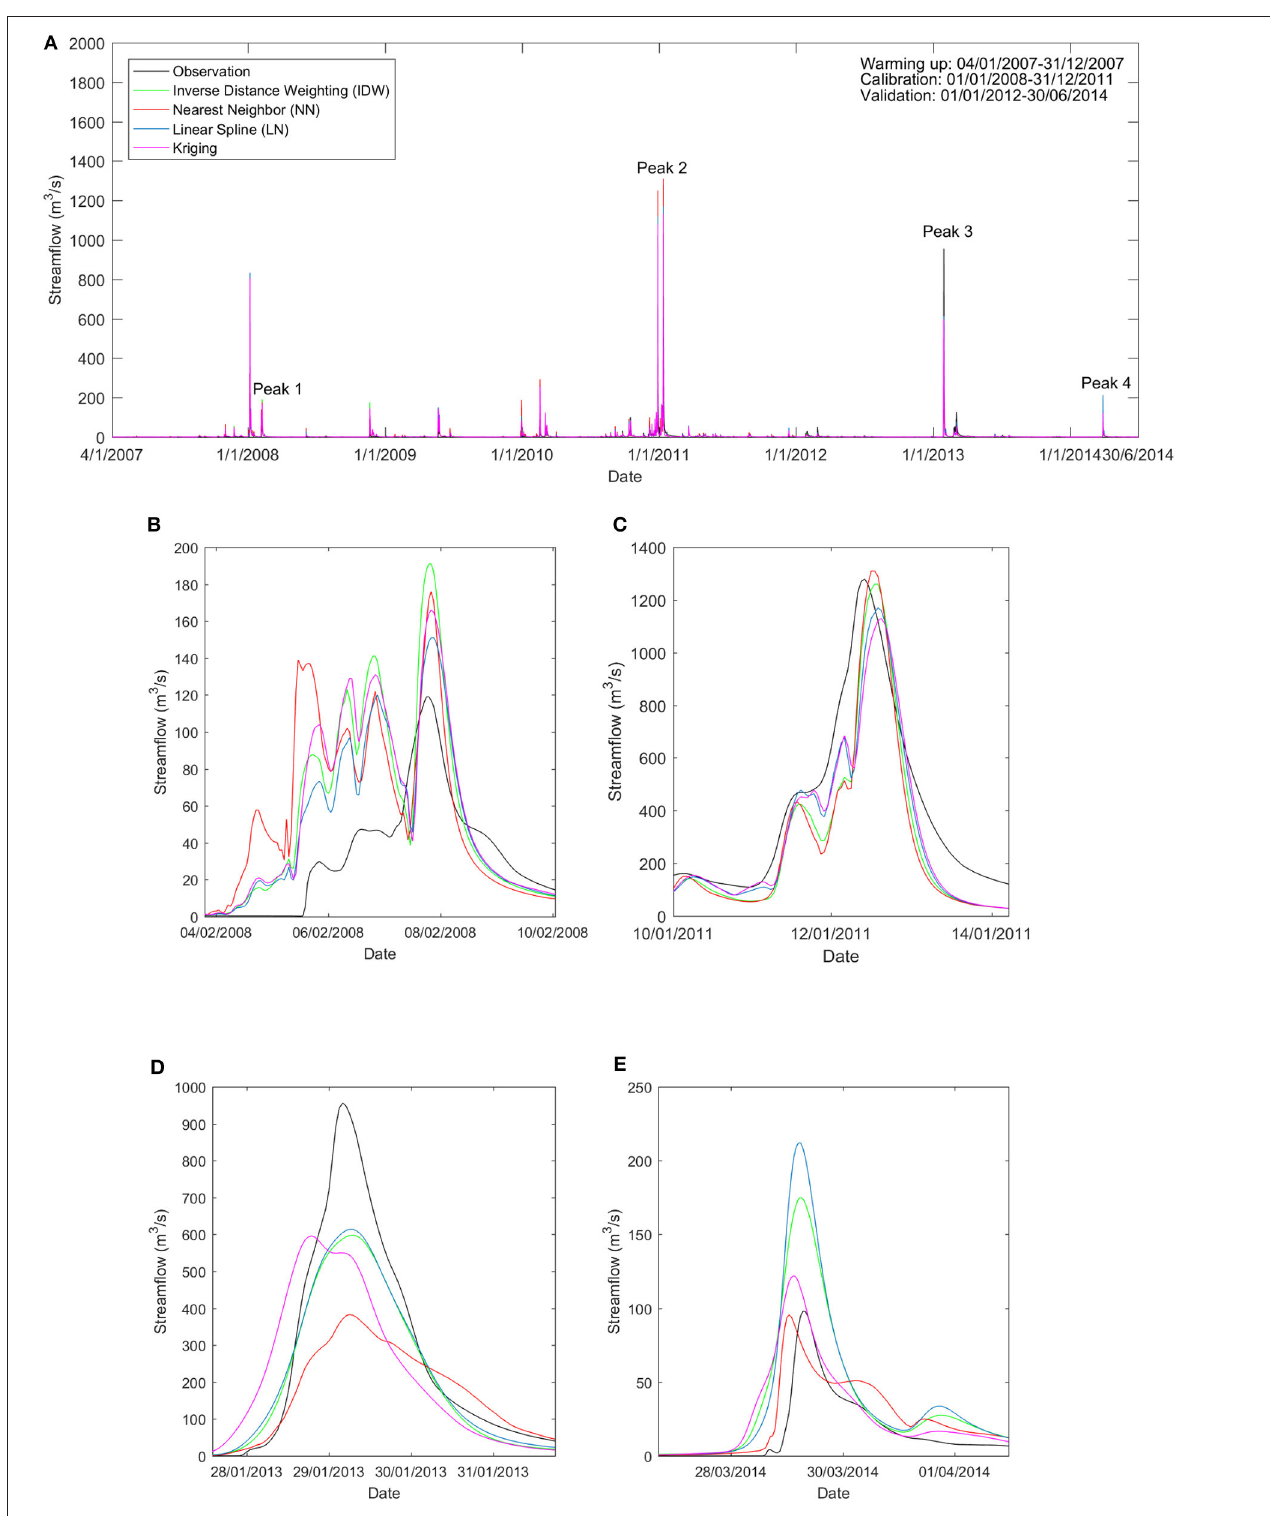
FIGURE 4 | Streamflow of observation and simulation forced by quality-controlled rainfall with different interpolation methods. (A) Streamflow during the entire timeline; (B) Streamflow peak 1 in February 2008; (C) Streamflow peak 2 in January 2011; (D) Streamflow peak 3 in January 2013; and (E) Streamflow peak 1 in March 2014.